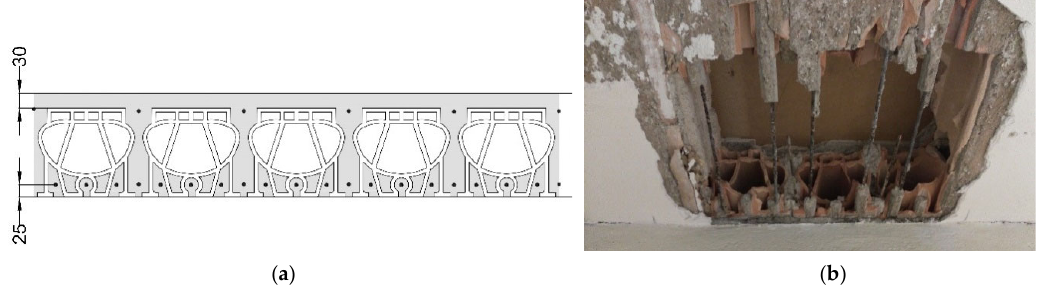
Figure 4. ( a ) Typical section of the analyzed slab; ( b ) View of an inspection which was carried out on the analyzed slab to extract samples.